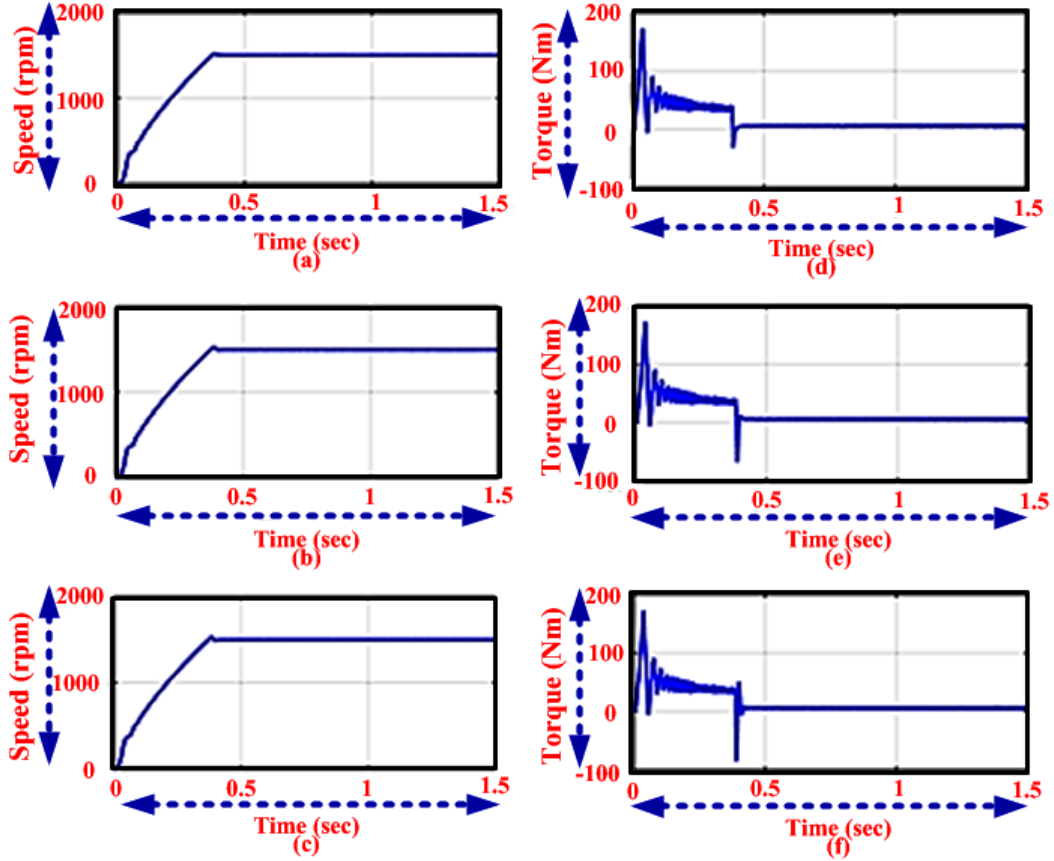
Figure 5. Analysis of Speed using the ( a ) proposed ( b ) moth-flame optimization (MFO) method and ( c ) proportional integral (PI) controller and Torque using the ( d ) proposed ( e ) MFO method and ( f ) PI